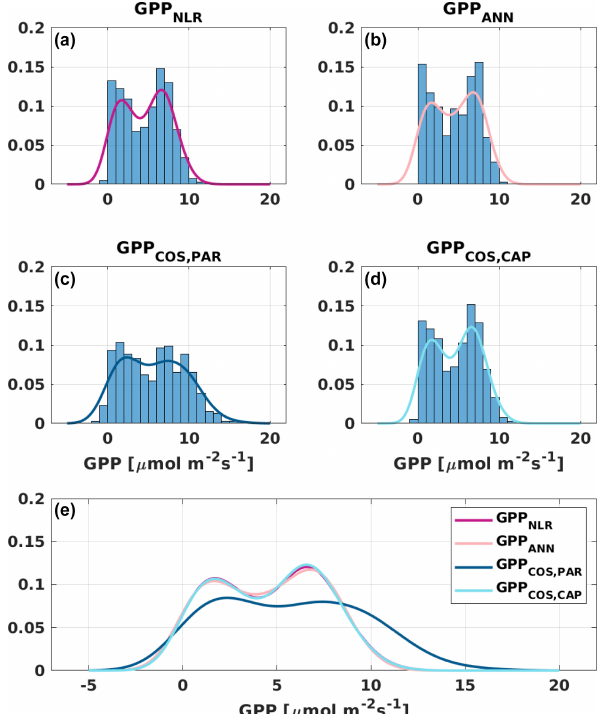
Figure 6. Distribution (bars) and probability density func- tions (lines) of daily average (a) GPP NLR , (b) GPP ANN , (c) GPP COS,PAR , and (d) GPP COS,CAP . All probability density func- tions are combined in (e) for better